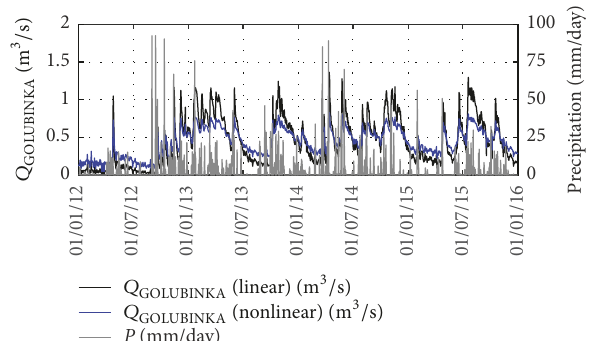
Figure 2: Limnigraphic data on the water level difference between the “sea” and “freshwater” side of the partition wall built on the spring itself and the precipitation data from the omnigraphic station Zadar.